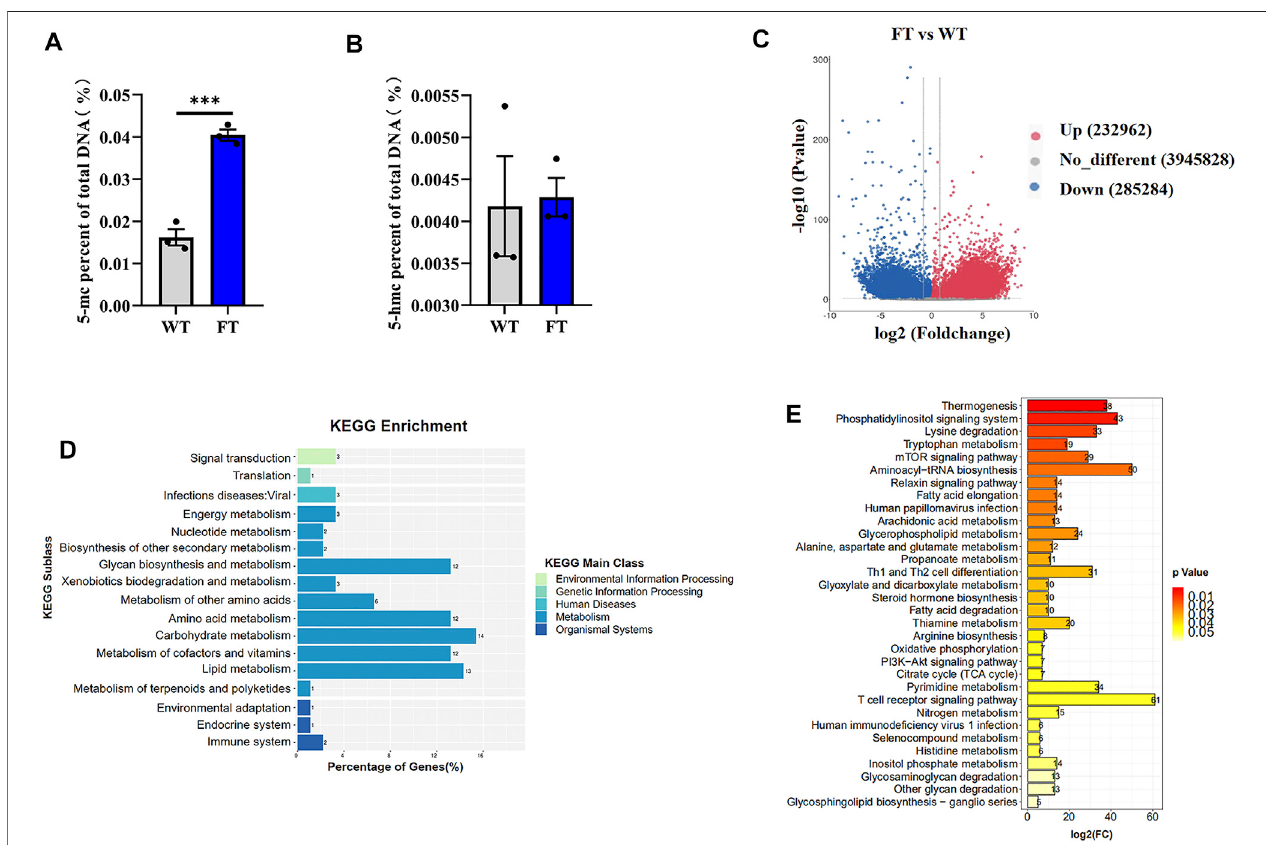
FIGURE 3 | DNA methylation is altered in fat-1 transgenic cells. (A,B) Content of 5-mC and 5-hmC were quanti fi ed using the MethylFlash methylated and hydroxymethylated colorimetric DNA quanti fi cation kits. Each dot represents an independent experiment. ( n = 3). (C) Methylation differences between fat-1 and control fi broblasts. In the plotted volcano plot, red dots represent signi fi cantly hypermethylated sites, blue dots represent signi fi cantly hypomethylated sites, and grey represent no signi fi cant difference. (D) KEGG pathway enrichment analysis. (E) KEGG classi fi cation enrichment analysis. All data are presented as mean ± SEM. Compared with the WT group, * p < 0.05, ** p < 0.01, *** p < 0.001, **** p < 0.0001; t-tests were used to calculate the p